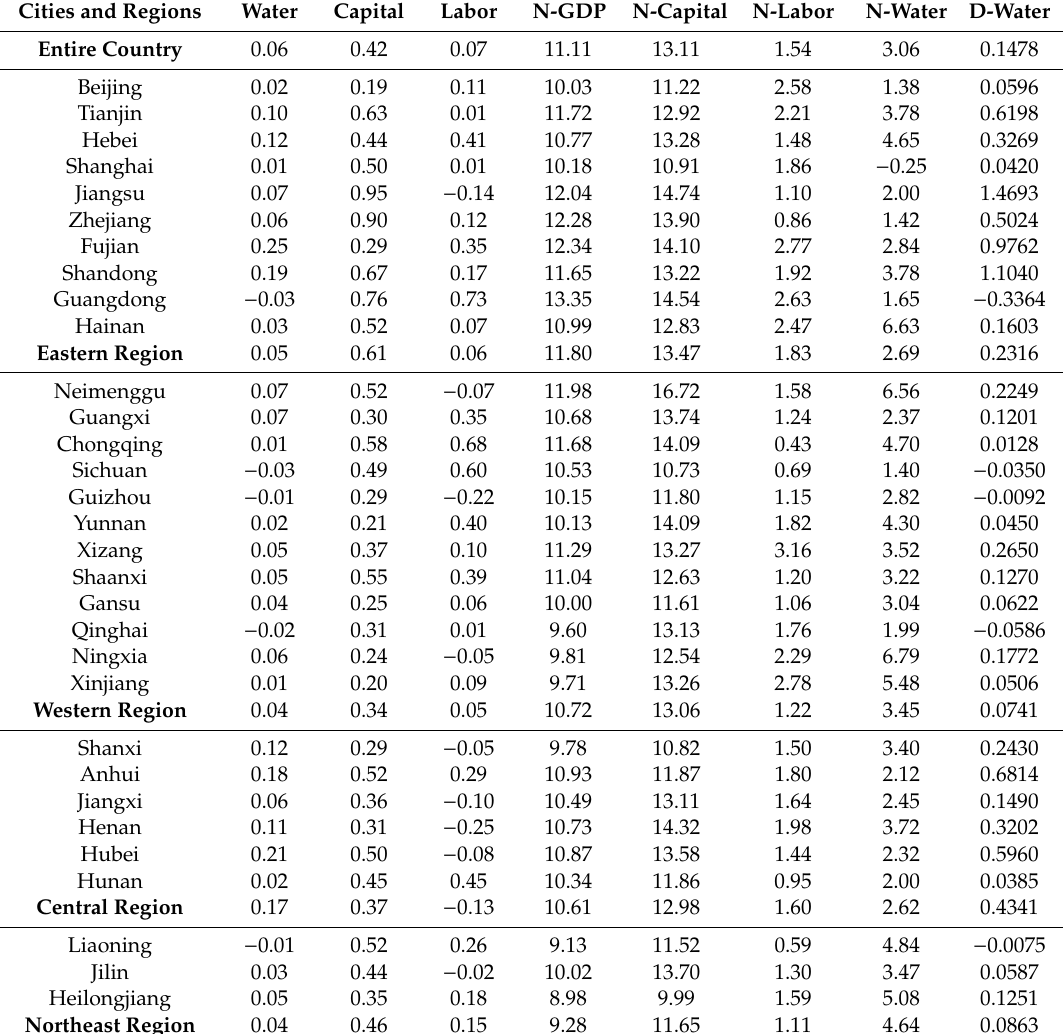
Table 4. Variable coe ffi cient panel model and “Drag” measurement results for China’s 31